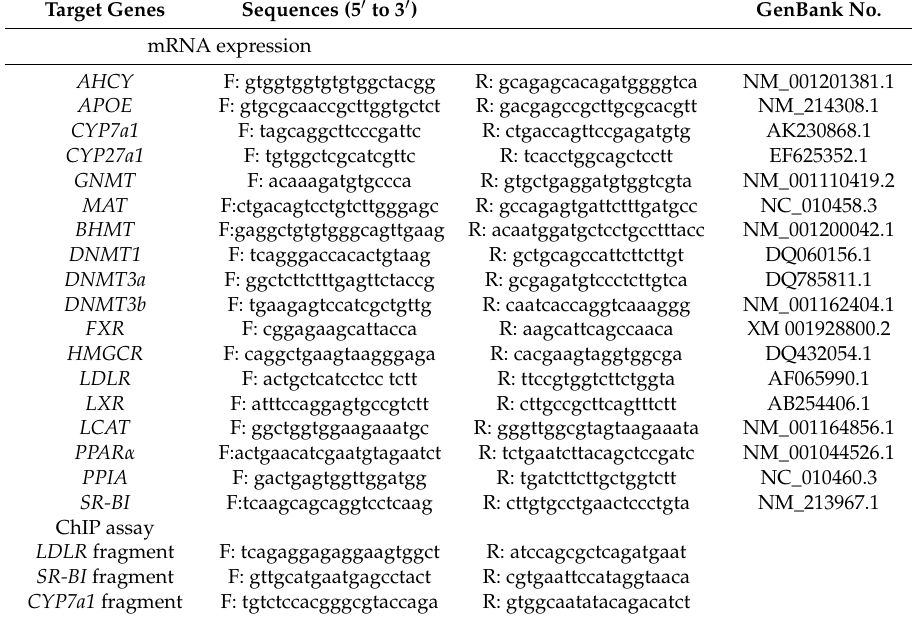
Table 2. Nucleotide sequences of specific